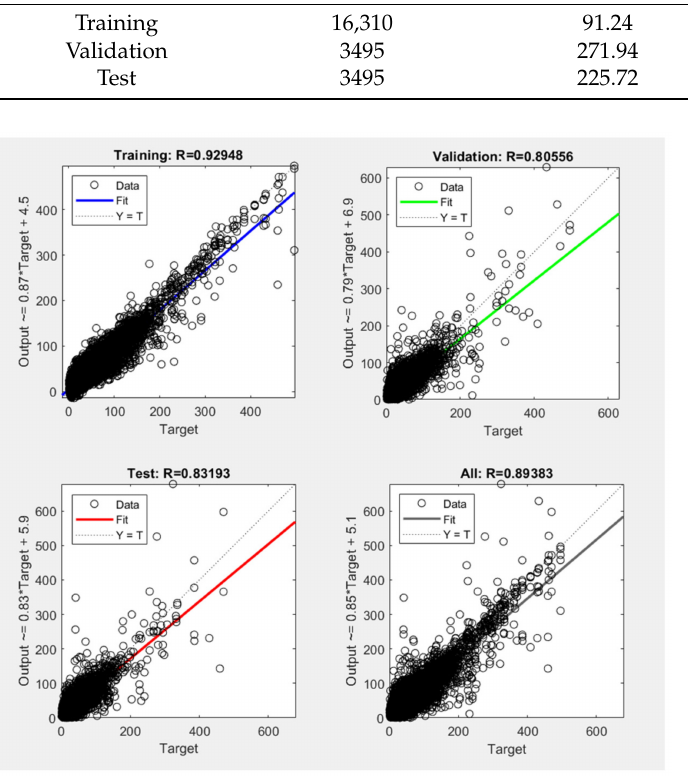
Figure 14. ANN regression statistics for individual sets and the total